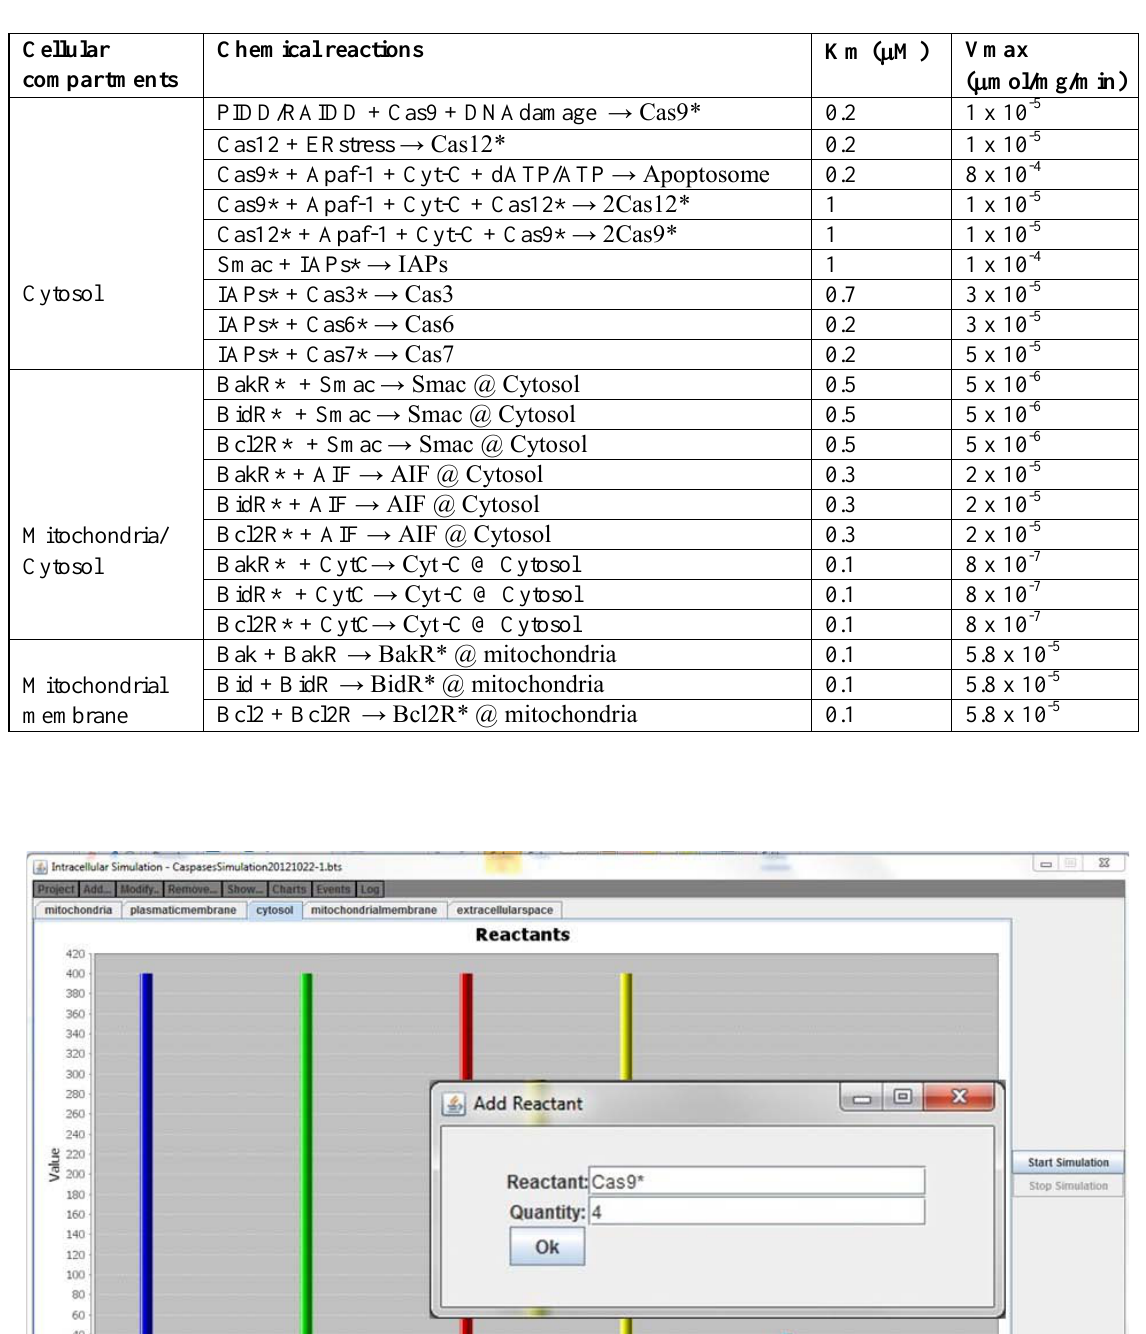
Table II: This table summarizes the biochemical interaction and kinetic parameters. The symbol “@” to the right of an equation indicates the cellular compartment in which the resultant reactant must be registered. Vmax is the maximum catalytic rate that can be achieved by a particular enzyme, Km is determined as the substrate concentration at which 1/2 Vmax is achieved.